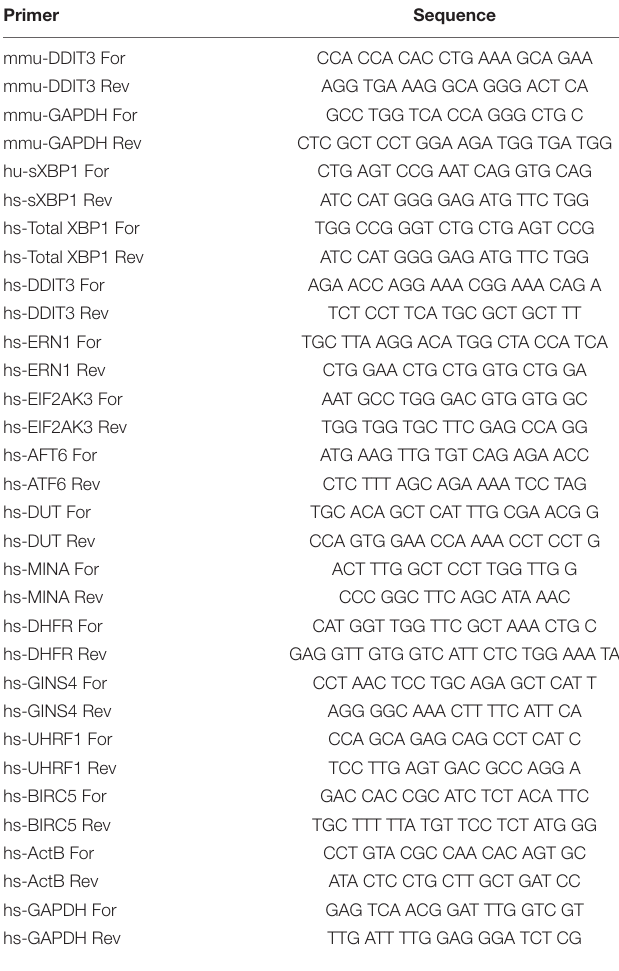
TABLE 1 | Oligonucleotide primers used for SYBR green based qRT-PCR assays. Primer Sequence